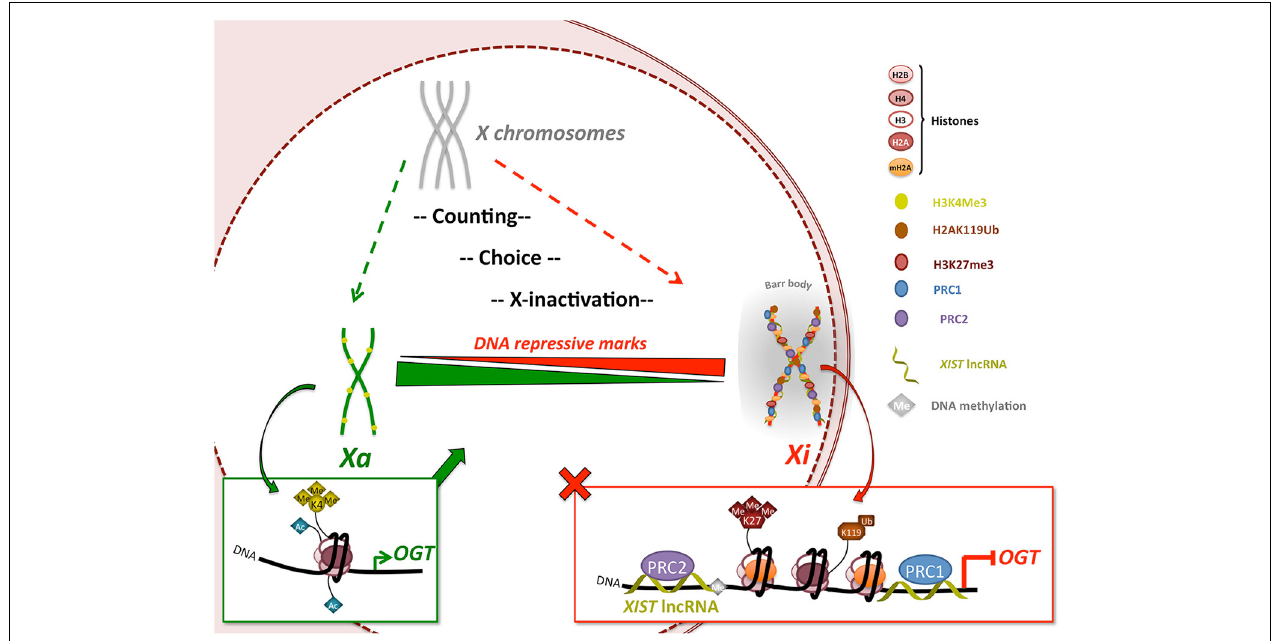
FIGURE 4 | OGT expression is regulated by X-inactivation in female mammals. The X-inactivation process begins with a counting/choice of which chromosome to inactivate. X-inactivation leads to silencing of almost the entire X-chromosome, including the XIST -proximal OGT gene, by recruitment of polycomb group proteins via XIST lncRNA and appearance of DNA repressive marks such as H3K27me3, H2AK119Ub and mH2A1. Once inactivation is completed,